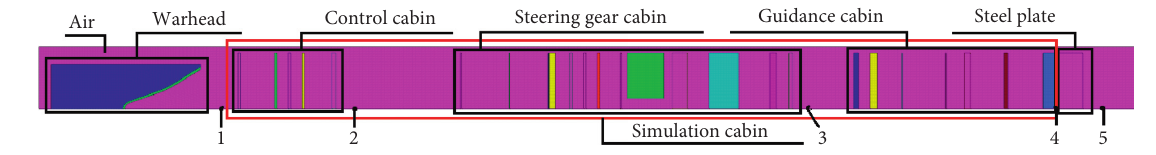
Figure 4: Schematic diagram of the observation point. Table 2: Material parameters for 8701 explosives.